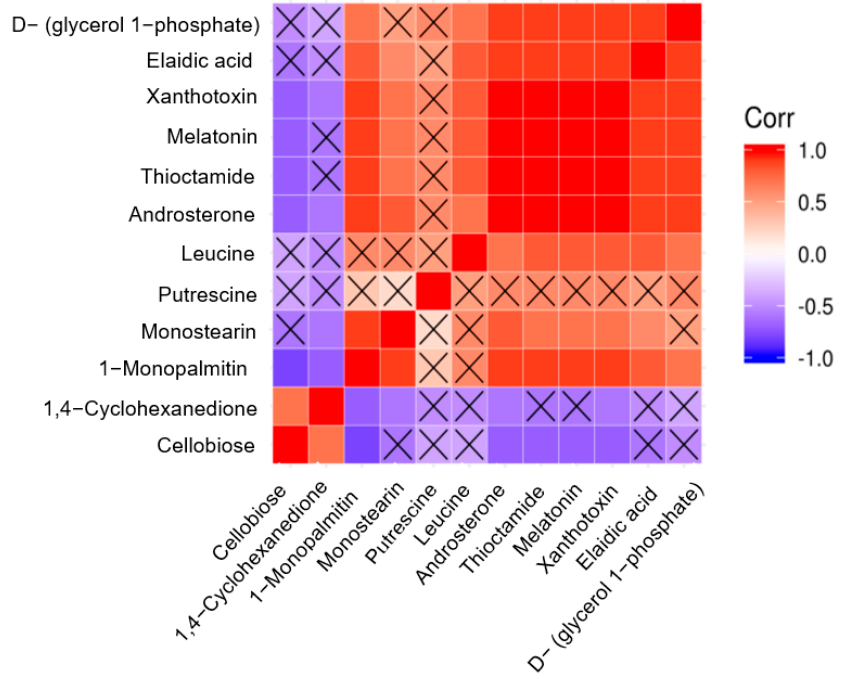
Figure 7. Thermal diagram of correlation analysis between group 1T and Group C.